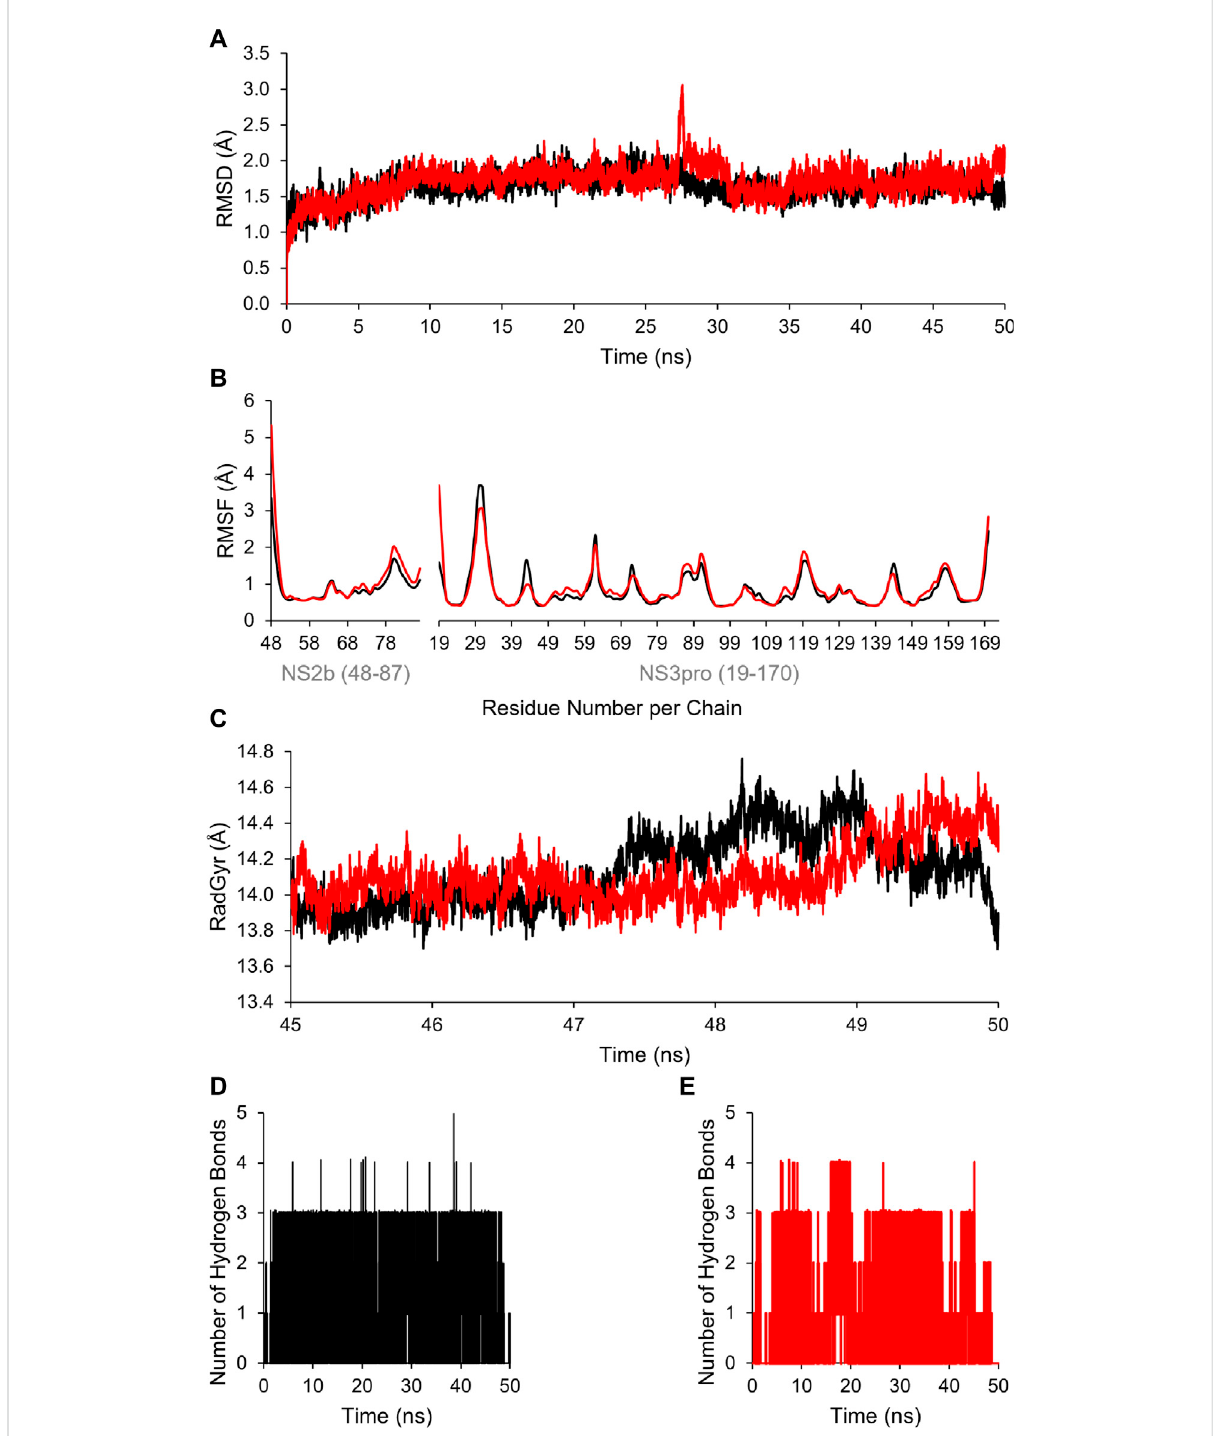
FIGURE 8 (A) Time evolution for the RMSD of NS2B/NS3 protease in complexes with compounds 4 (black) and 5 (red). (B) RMSF values of NS2B/ NS3proteaseresidueswhenincomplexwithcompounds 4 (black)and 5 (red). (C) Radiusofgyration(RadGyr)ofNS2B/NS3proteaseincomplexwith compounds 4 (black) and 5 (red). (D,E) Number of H-bonds formed between the amino acid residues at the catalytic binding site of NS2B/ NS3 protease when in complex with compounds 4 (black) and 5 (red),